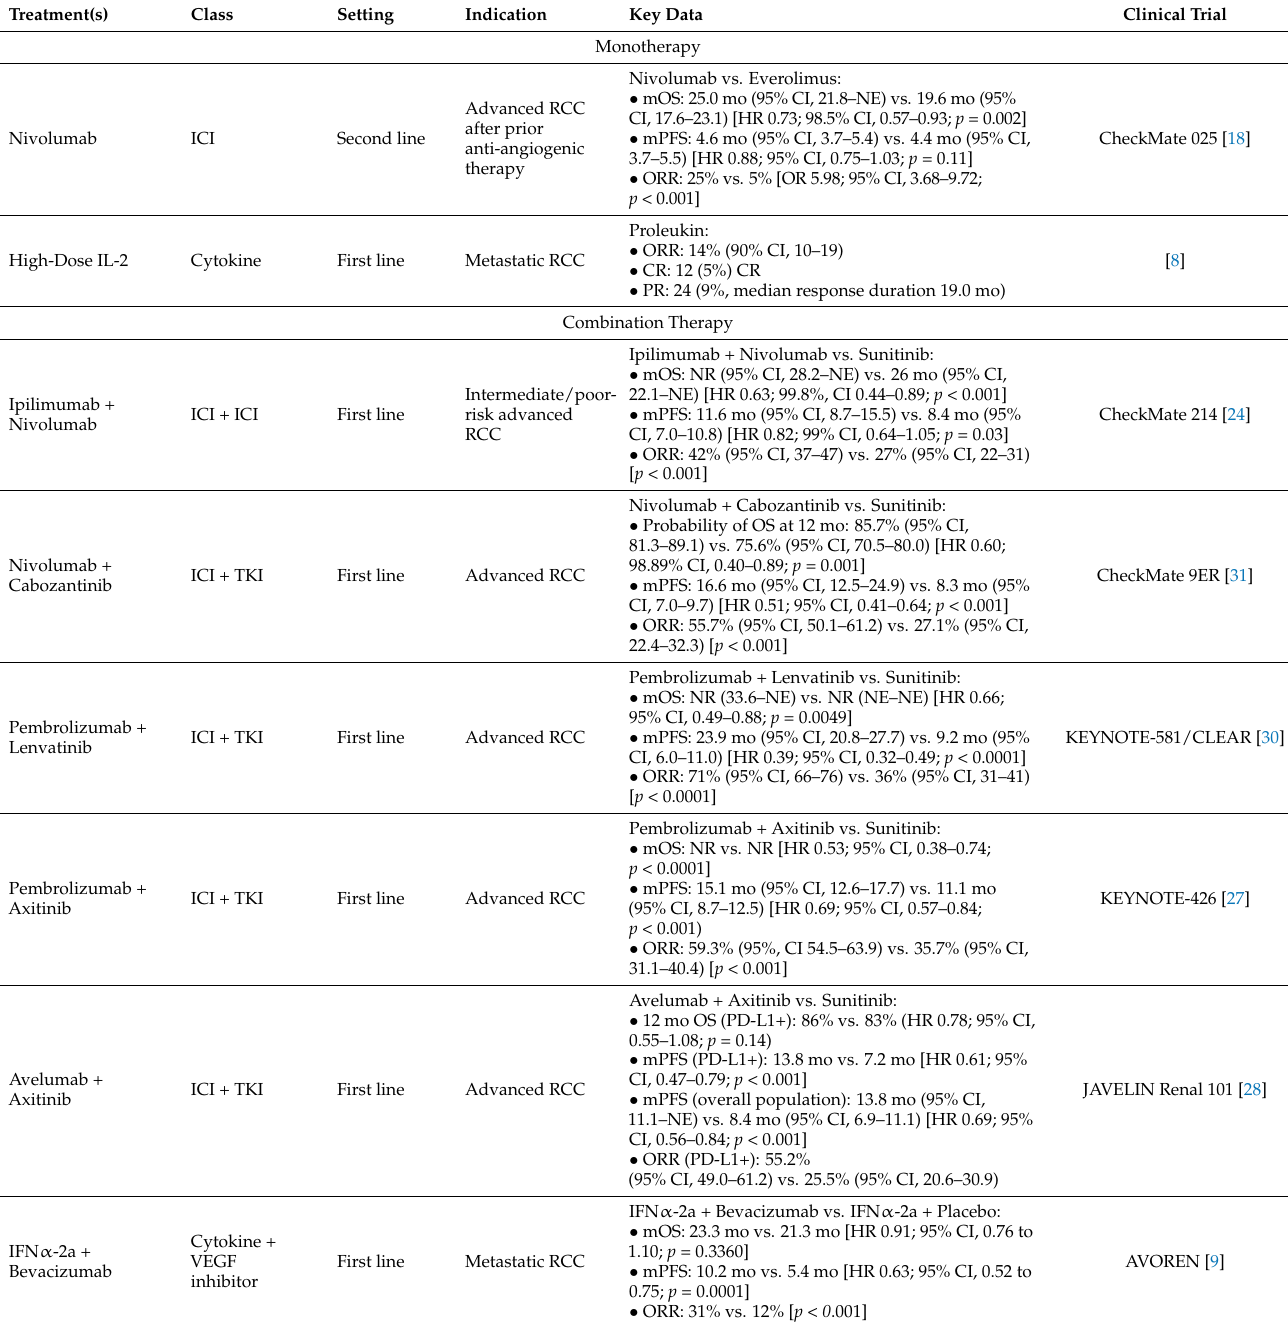
Table 1. Approved immunotherapies for